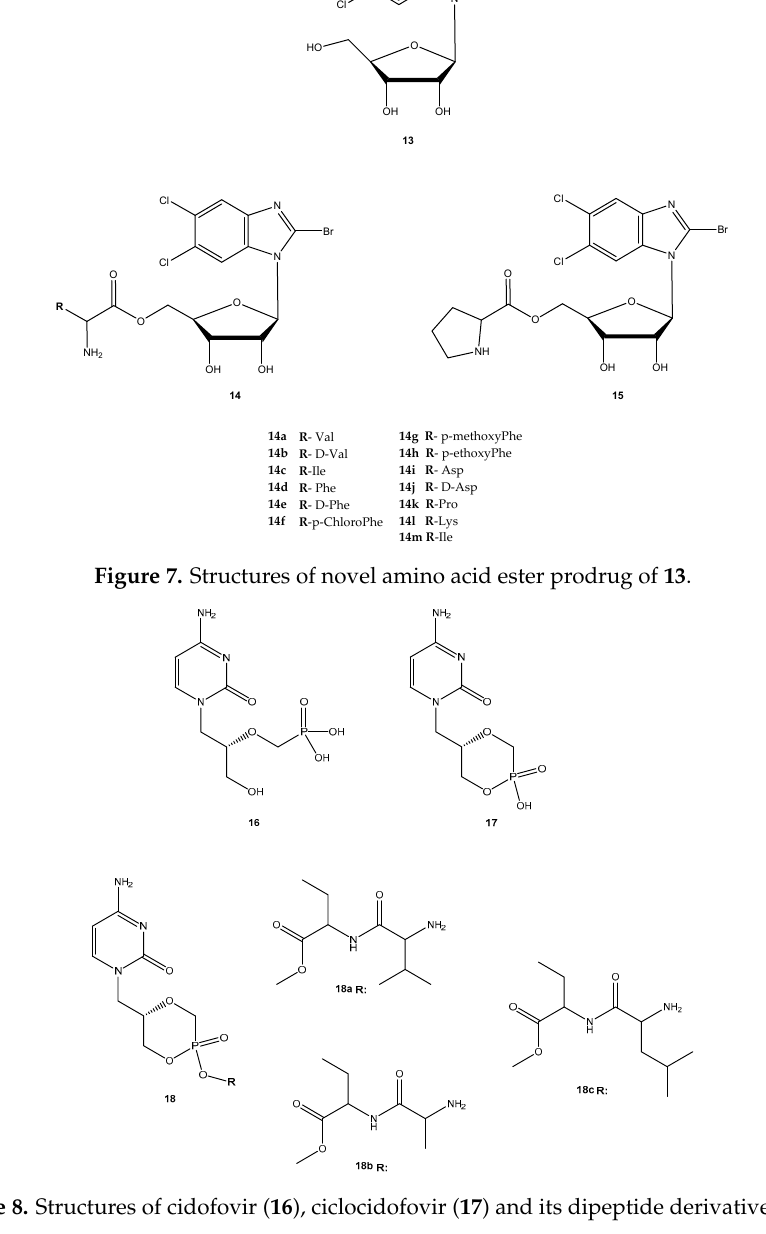
Figure 8. Structures of cidofovir ( 16 ), ciclocidofovir ( 17 ) and its dipeptide derivatives 18a – c .